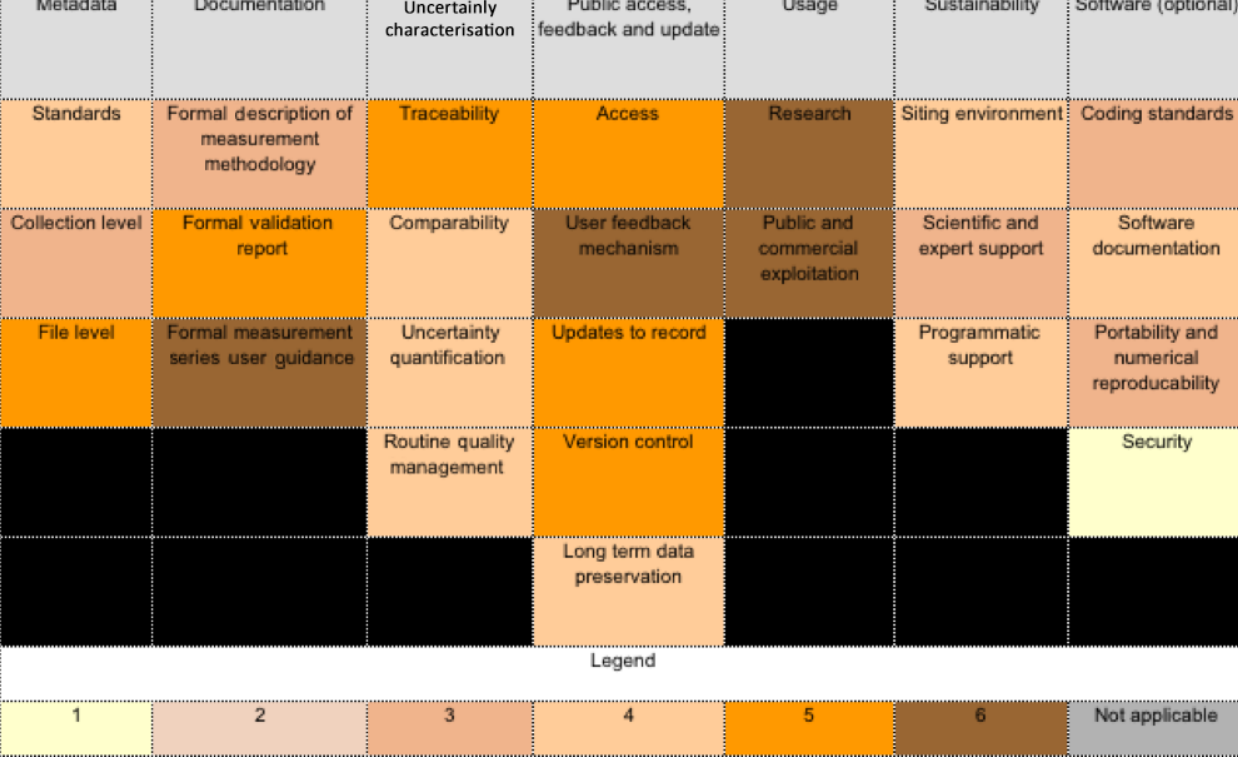
Figure 3. Example maturity matrix assessing the NDACC (Network for the Detection of Atmospheric Composition